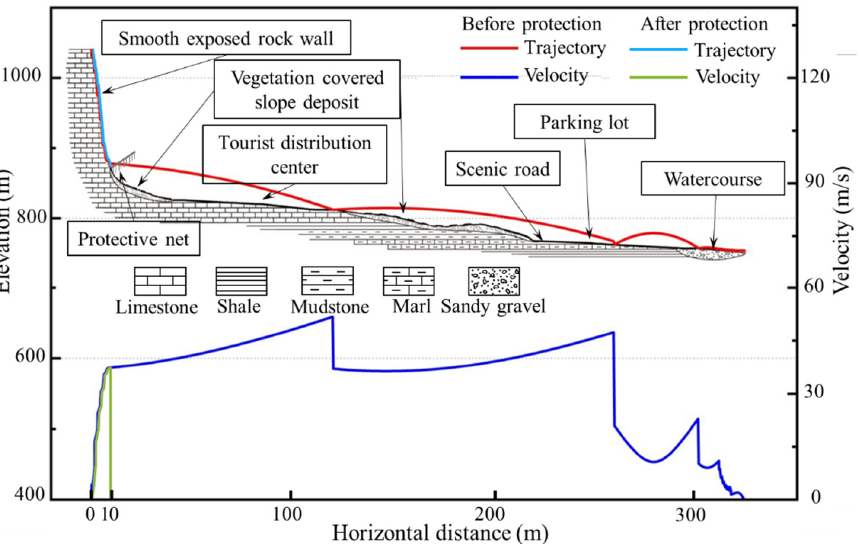
Figure 21. Comparison of typical rockfall trajectories for the scenic spot of Sky City before and after placing passive protection nets (the location of the typical rockfall trajectory see Figure 20a).